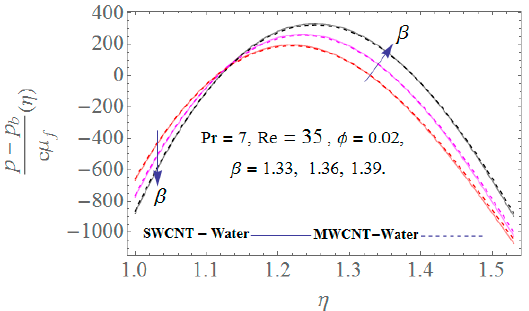
Figure 13. Impact of the thickness parameter versus pressure distribution.